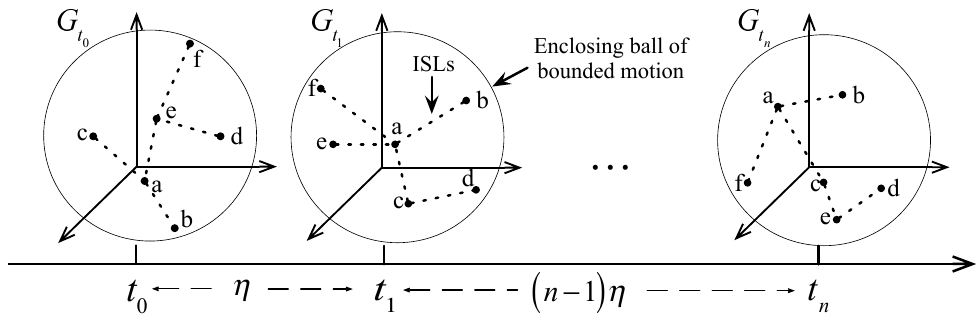
Figure 2. An example of topology changing varying with